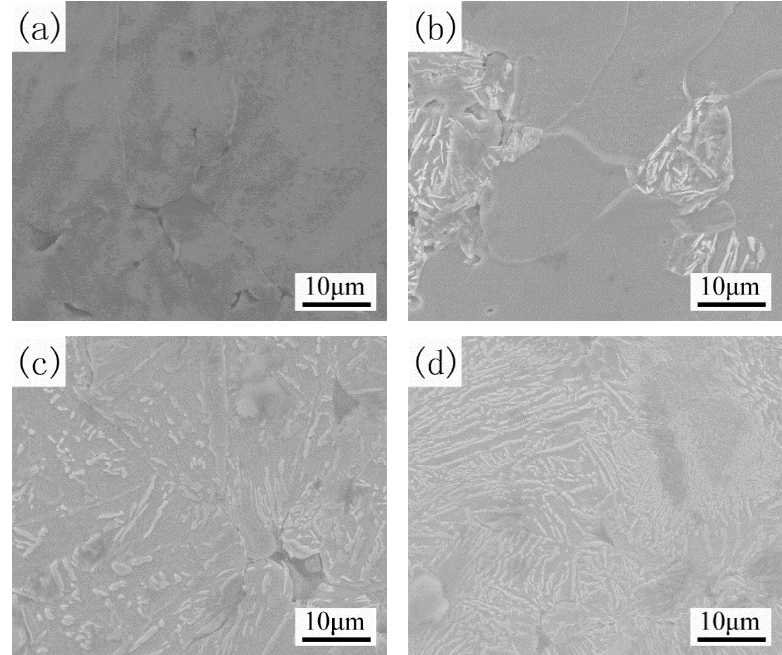
Figure 8. SEM images of the densified layer in specimens of ( a ) 0 C; ( b ) 0.2 C; ( c ) 0.45 C; and ( d ) 0.8 C.